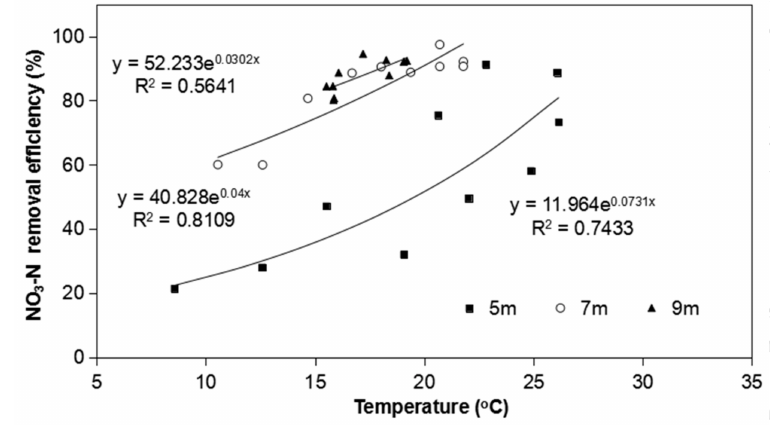
Figure 7. The relationship between NO 3 -N removal efficiency and groundwater